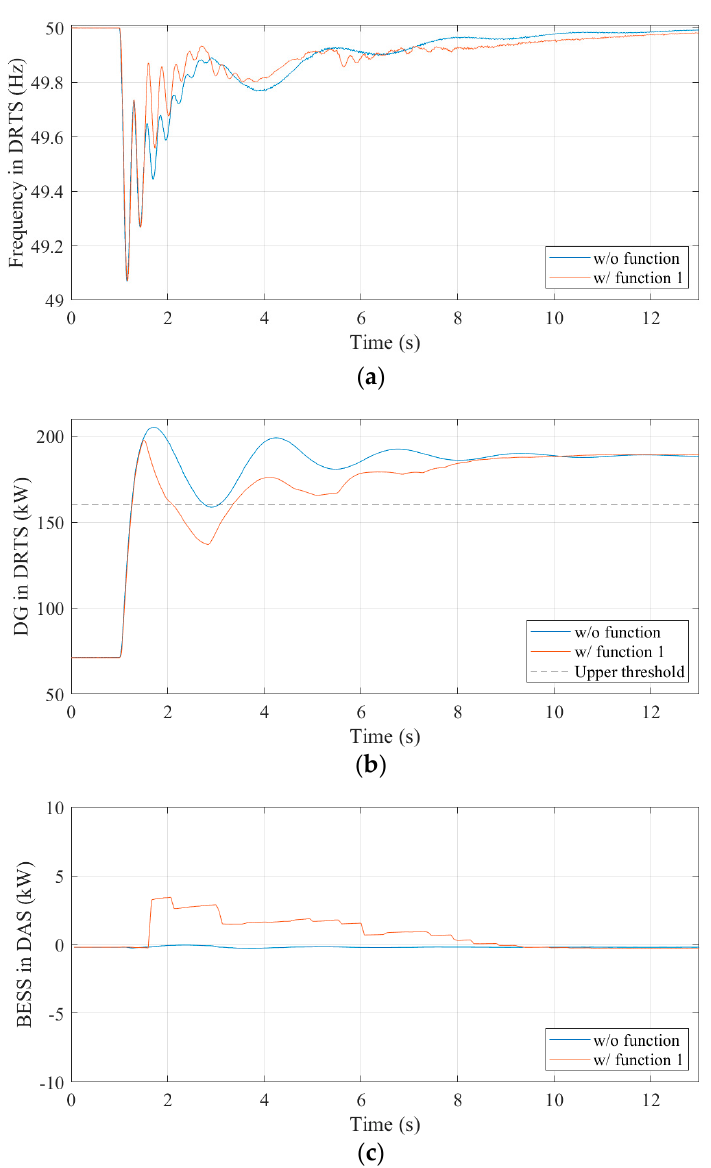
Figure 6. Function 1 results (load increase from 7 kW to 19 kW): ( a ) frequency; ( b ) DG set output; ( c ) BESS output. Note that 10 times scaled measurement of actual lab equipment output, i.e., BESS and load, is fed back to the DRTS in this PHIL